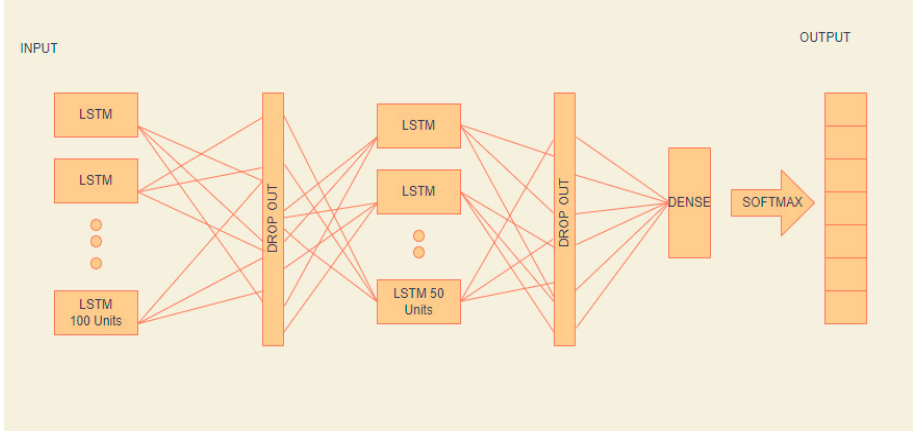
Figure 8. Long short term memory architecture.